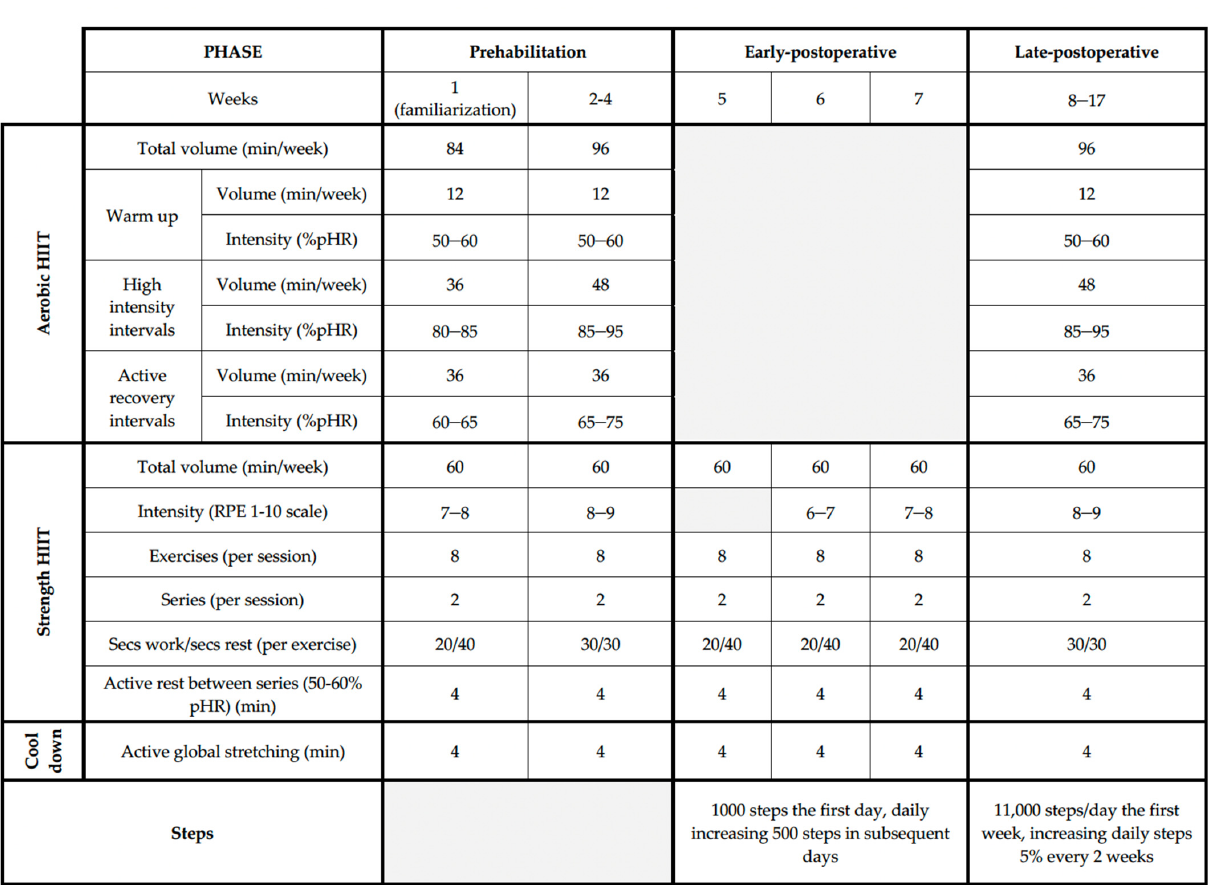
Figure 2. Training periodization of the ONCOFIT study. Abbreviations: HIIT; High Intensity Interval Training, pHR; peak Heart Rate, RPE; Rating Perceived Exertion.